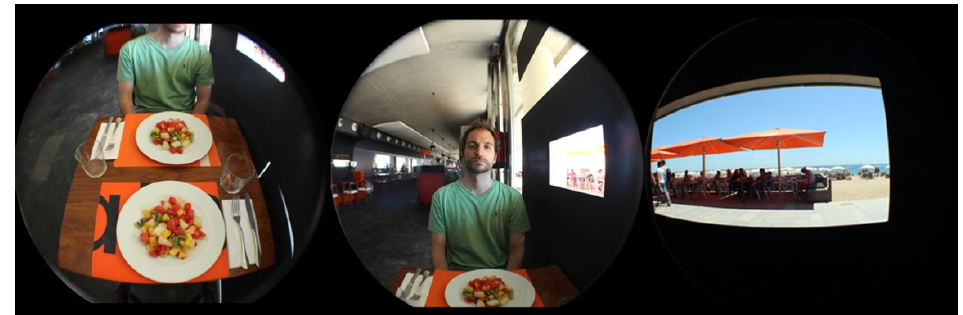
Figure 7 . Real pictures of window façade system of Sal Café restaurant with each workplane; table, a person in front and windows (in the left, small window; in the middle, medium right window; and in the right, central large window). Indications for glare source surface; table WP, part of the window in the right; person WP, the window in the right; and window WP, the window in the centre.